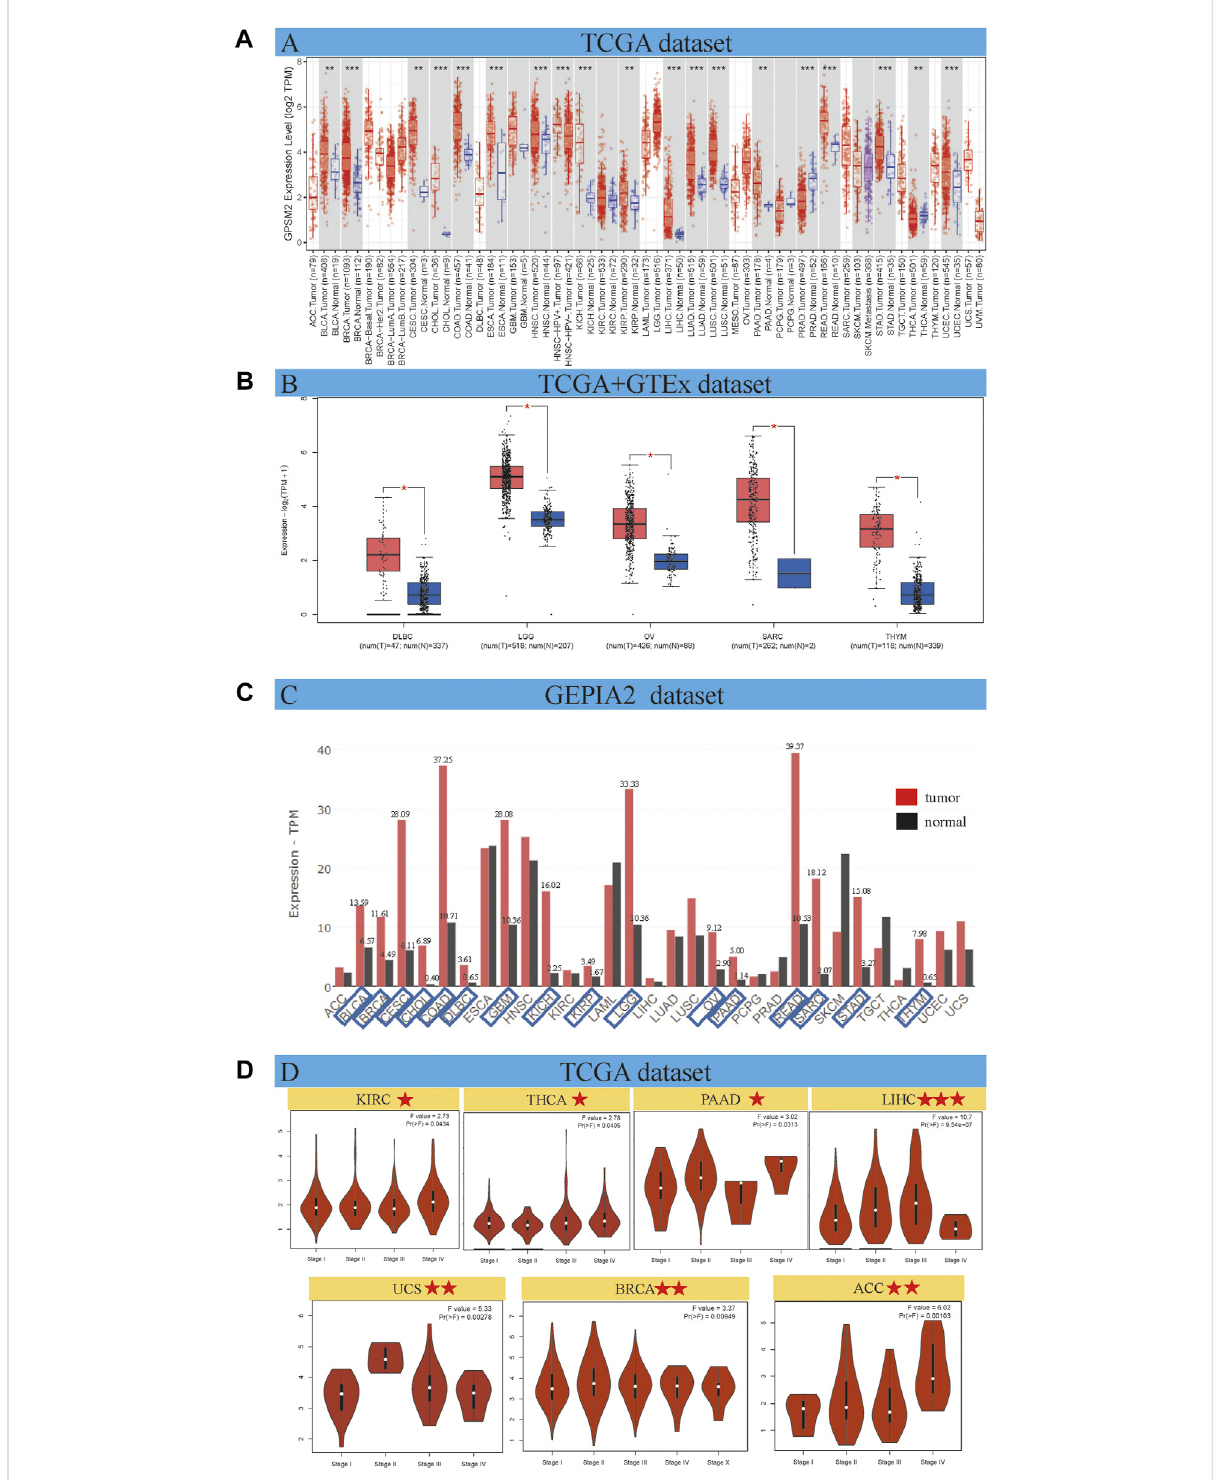
FIGURE 1 GPSM2 expressioninvarioustumorsandpathological stages. (A) GPSM2 expressiondifferencebetweentumorandadjacentnormal tissues. (B) TheGTEx datasetshows ablockdiagramoftheTCGAdatasetlacking GPSM2 expression data. (C) Differencesin GPSM2 totalproteinlevels between cancer and normal tissues. (D) Stage-speci fi c GPSM2 expression across cancers (* p < 0.05; ** p < 0.01; *** p <